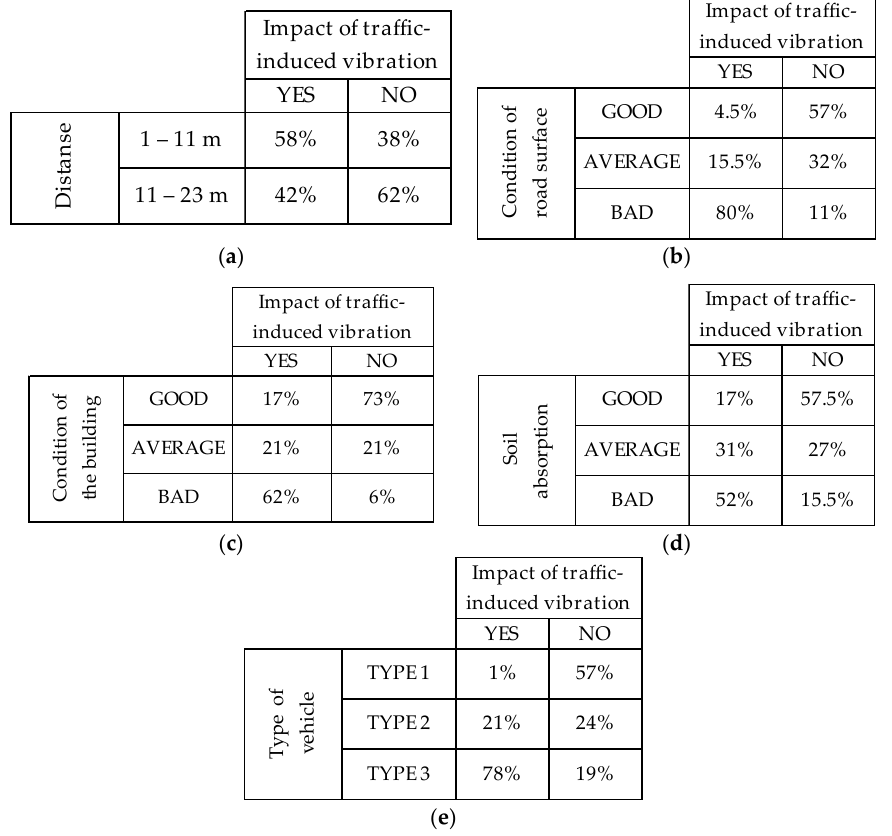
Figure 2. Tables of conditional probabilities for different variables: ( a ) Distance; ( b ) condition of the road; ( c ) condition of the building; ( d ) absorption of soil and ( e ) type of passing vehicle.